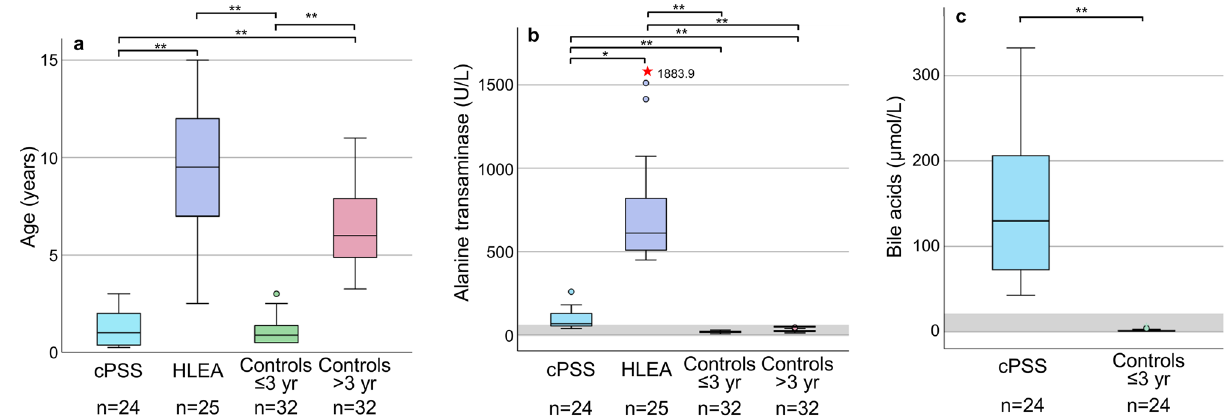
Figure 1. ( a ) Age, ( b ) alanine transaminase activities (ALT), and ( c ) bile acid (BA) concentrations in serum samples from dogs with cPSS (n = 24), HLEA (n = 25), and younger and older adult control dogs (n = 32, for each). Bile acid concentrations were determined in all dogs with cPSS and in 24 of 32 controls dogs of ≤ 3 yr. Boxes indicate the lower to upper quartile (25th–75th percentile), and median value. Whiskers extend to minimum and maximum values. Outliers are shown as individual open circles or red stars. Grey boxes indicate reference intervals. Lines above figures reflect significant differences between specific groups (* p < 0.05; ** p <